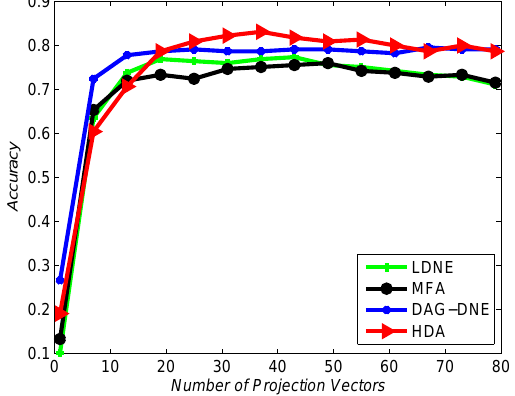
Figure 4. Accuracy vs. Number of Projection Vectors on the Yale dataset under K =